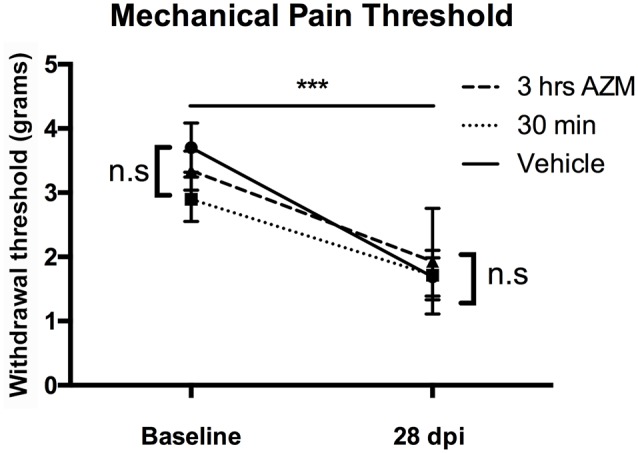
AZM administration does not alter the development of mechanical allodynia in mice after SCI. Gram-force withdrawal threshold to Von Frey filaments stimuli decreased after SCI, relative to baseline, indicative of the development of allodynia after SCI (***p > 0.0001). However, AZM did not alter the development of allodynia at 27 dpi relative to vehicle (n.s. = not significant, p = 0.89). There were no baseline differences in withdrawal threshold prior to injury (p = 0.29). n = 15–20, mean ± SEM.